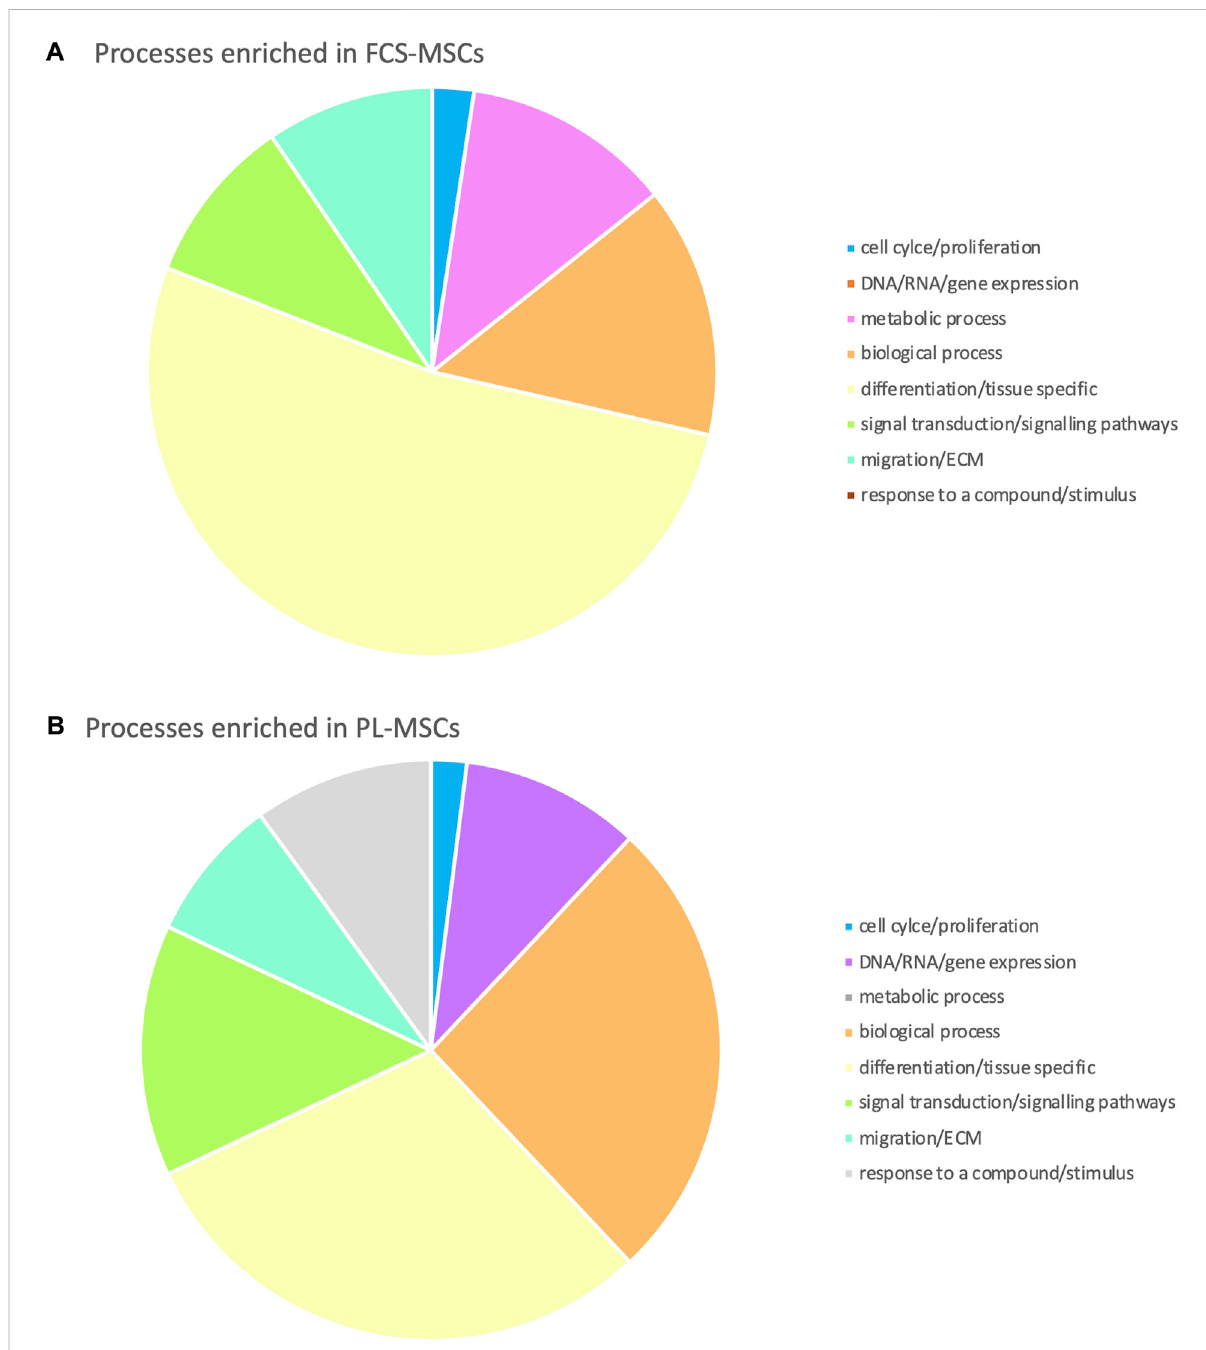
FIGURE 3 Gene Ontology analysis: processes enriched in (A) FCS-MSCs and (B) PL-MSCs (q ≤ 0,05, false discovery rate adjusted p value ≤ 0,05). Enriched processes are grouped in 8 major categories to get a better overview of processes impacted by differential expression due to use of a different growth